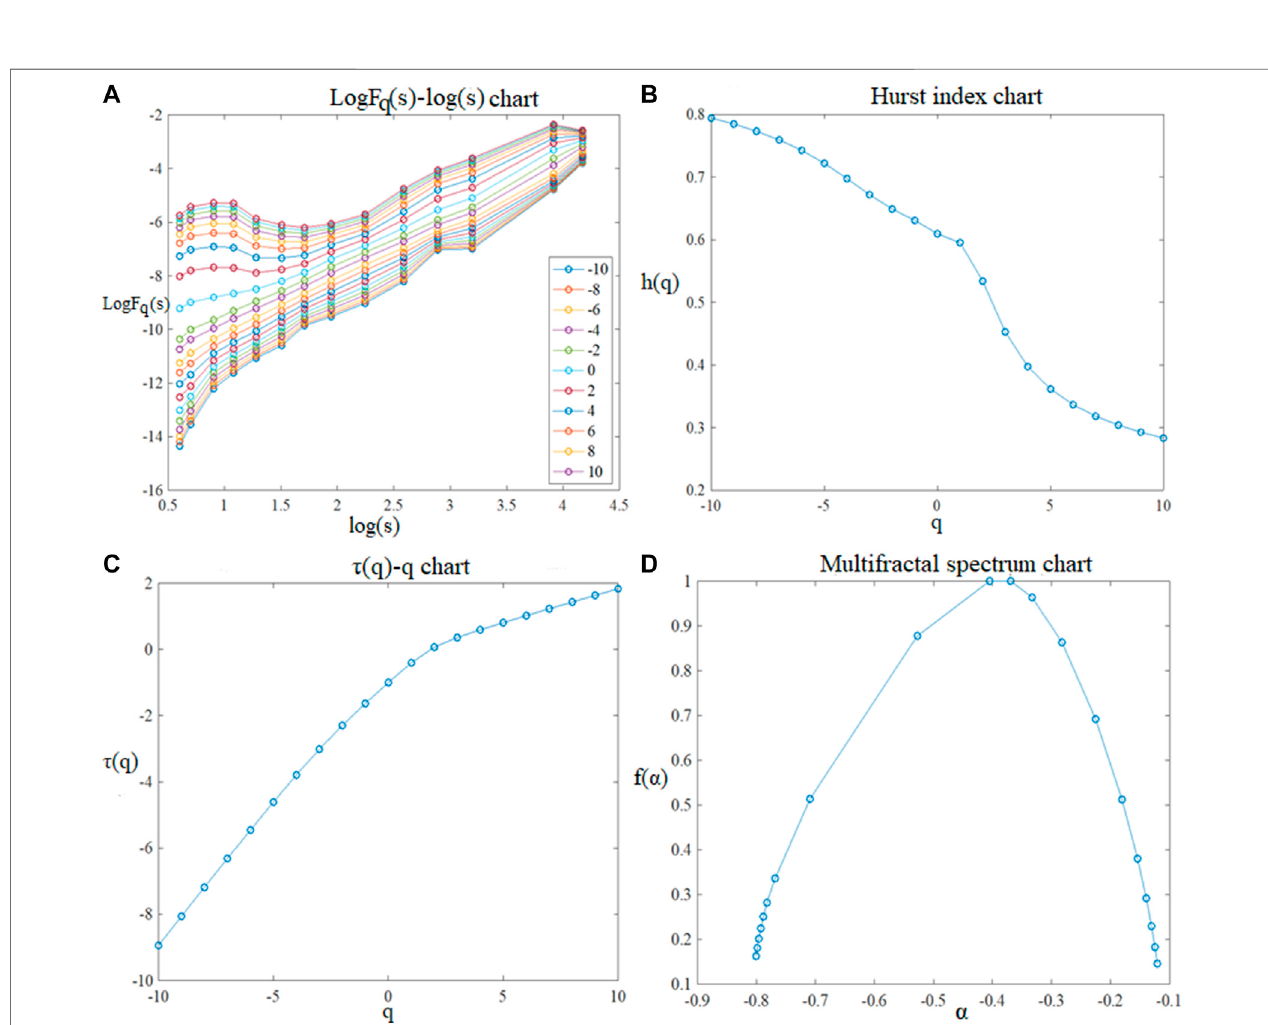
FIGURE 2 | Multifractal features analysis of China ’ s crude oil futures market with the EMD-MFDFA.